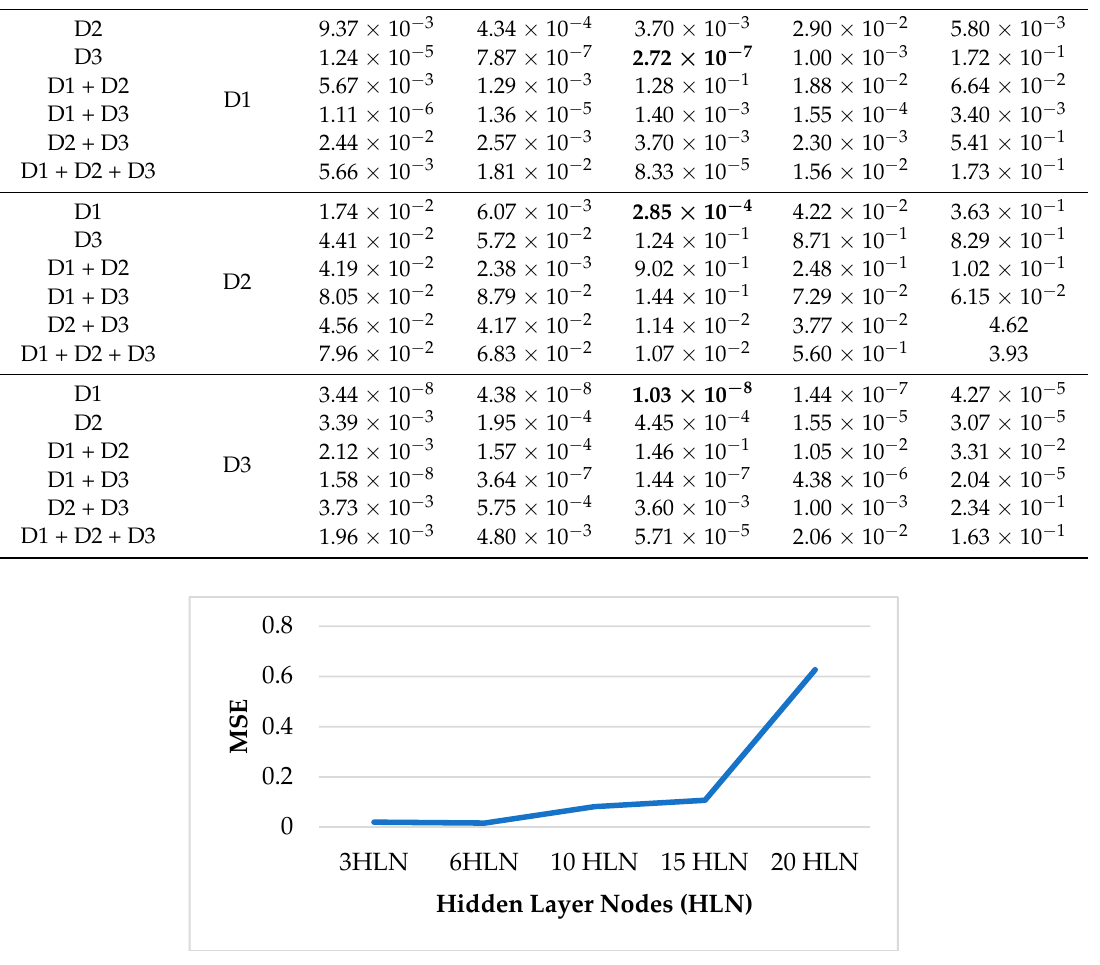
Figure 17. NARX Neural Network performance vs. hidden layer nodes.